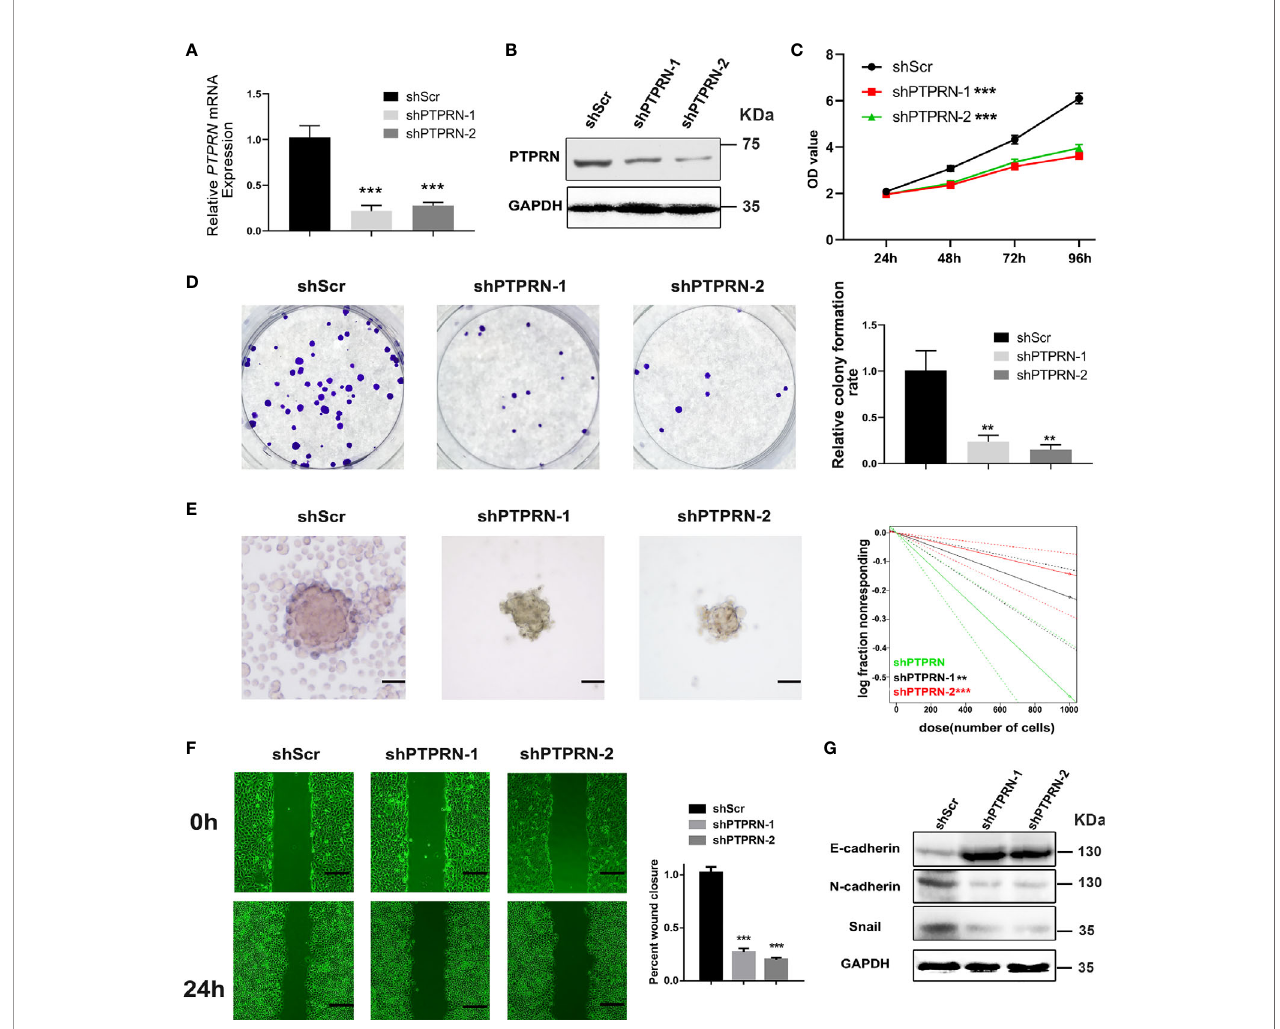
FIGURE 2 | PTPRN downregulation reduced the proliferation and migration of U87 cells. (A, B) The level of PTPRN was assayed by RT-qPCR and western blot analysis after transfection with PTPRN-shRNA; (C) The proliferation of the cells was detected by CCK-8; the corresponding OD values were detected at 24 h, 48 h, 72 h and 96 h; (D) The proliferation of the cells was detected by colony formation assays; the results were recorded using a camera at 14 days; (E) Sphere formation detected by microscope and calculated by ELDA after 14 days; (F) The migration of the cells detected by wound healing assay; the scratch was imaged at 0 and 24 h; The area of scratch reduction was calculated; (G) EMT-related protein (E-cadherin, N-cadherin, and Snail) expression in shPTPRN U87 cells; scale bars, 100 m m; **p < 0.01, ***p <